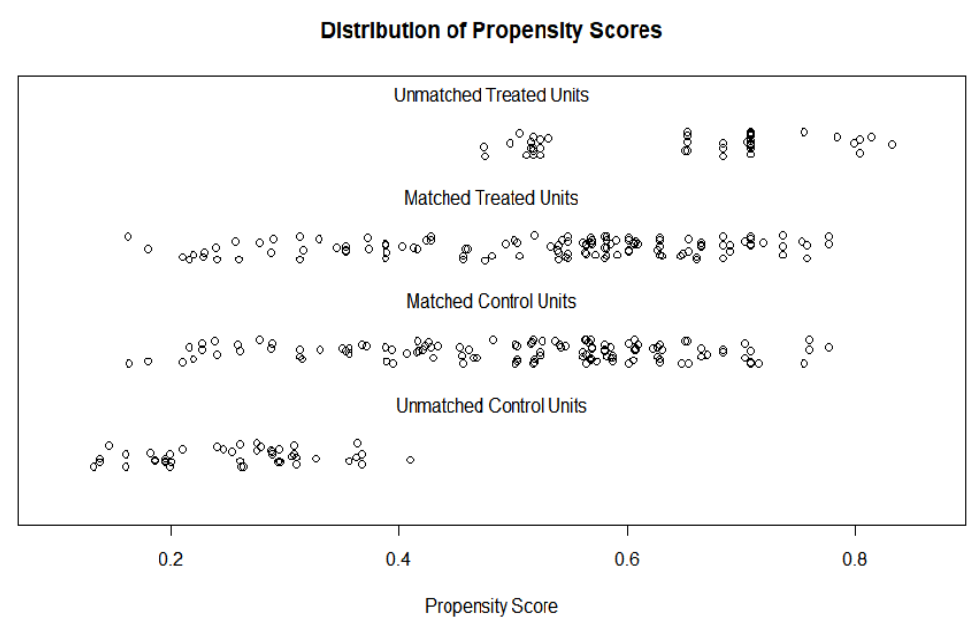
Figure 2. Distribution after propensity score.